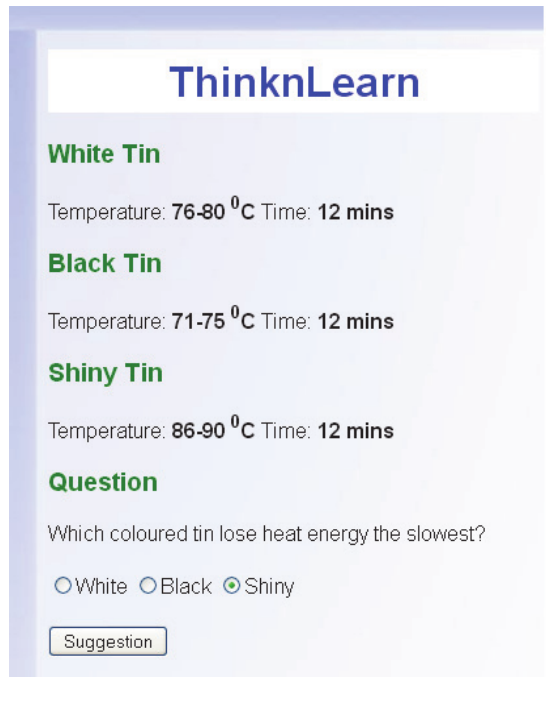
Figure 10 . MCQ regarding one of the aspects of heat energy.